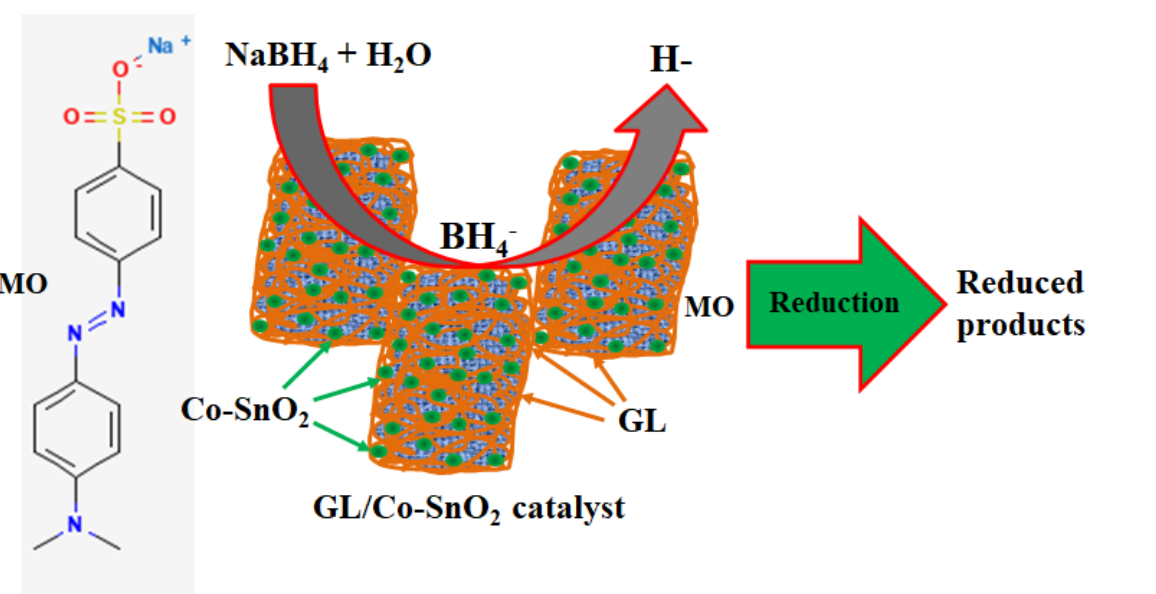
Figure 9. Catalytic reduction of MO in the presence of NaBH 4 onto the GL/Co − SnO 2 nanocomposite catalyst.